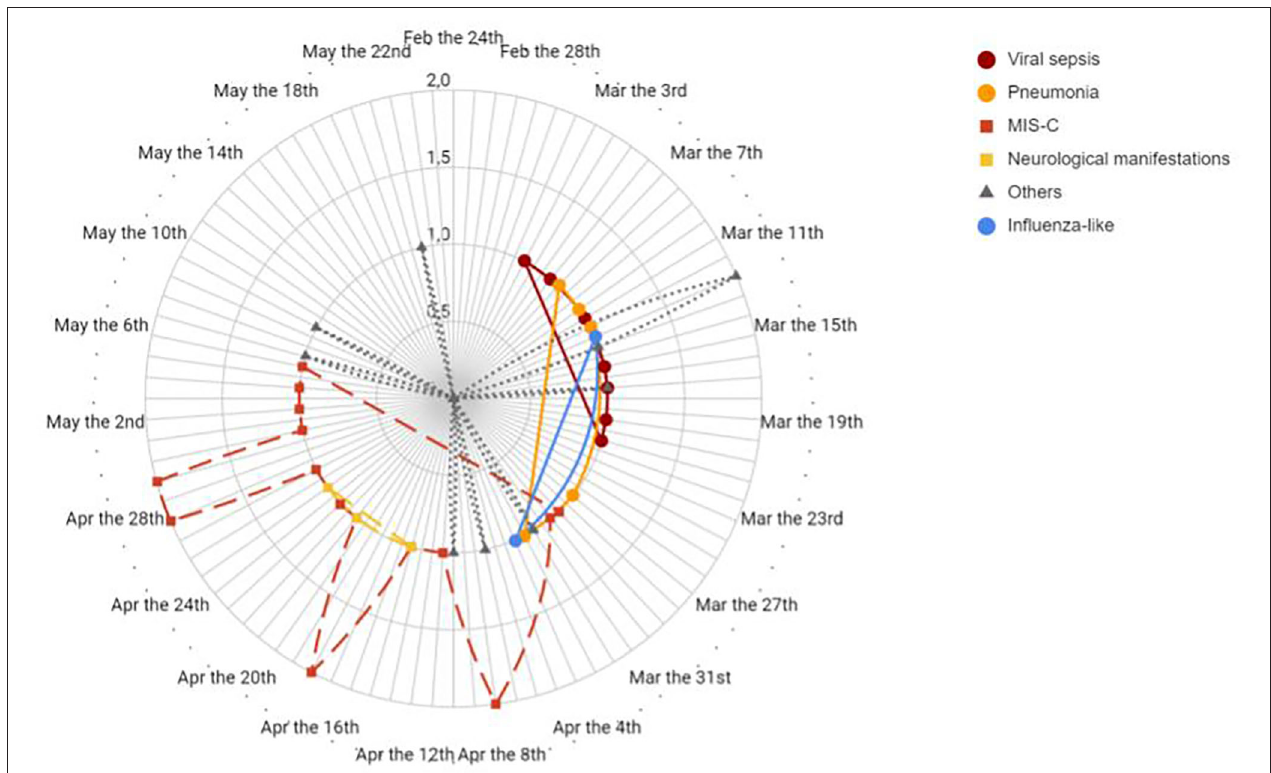
FIGURE 2 | Timeline distribution of patients divided by clinical pattern of presentation diagnosis. Solid line indicates diagnosis of viral sepsis, pneumonia and influenza like symptoms in different shades of grey. Dashed line indicates diagnosis of MIS-C and neurological manifestations. Dotted line indicates other diagnosis. with a viral infection or SARS-CoV-2 immune-mediated